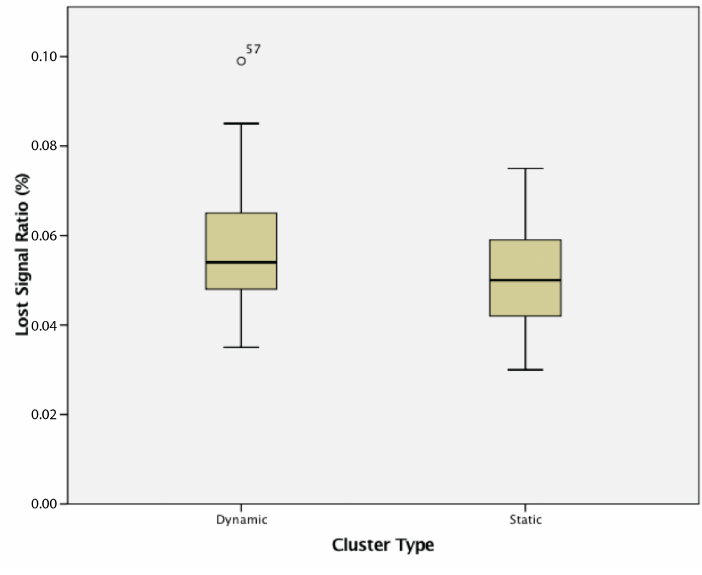
Figure 25. Lost signal ratio of static and dynamic wireless sensor